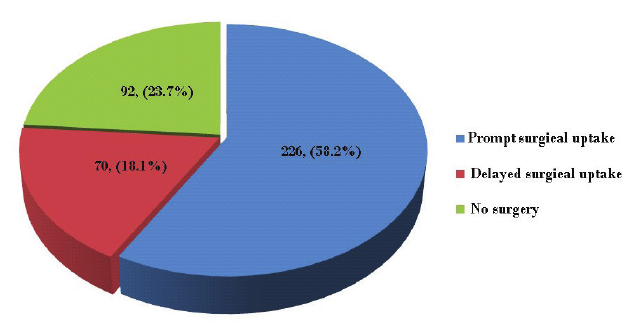
Figure 1 - Level of uptake of cataract surgeries among cataract patients